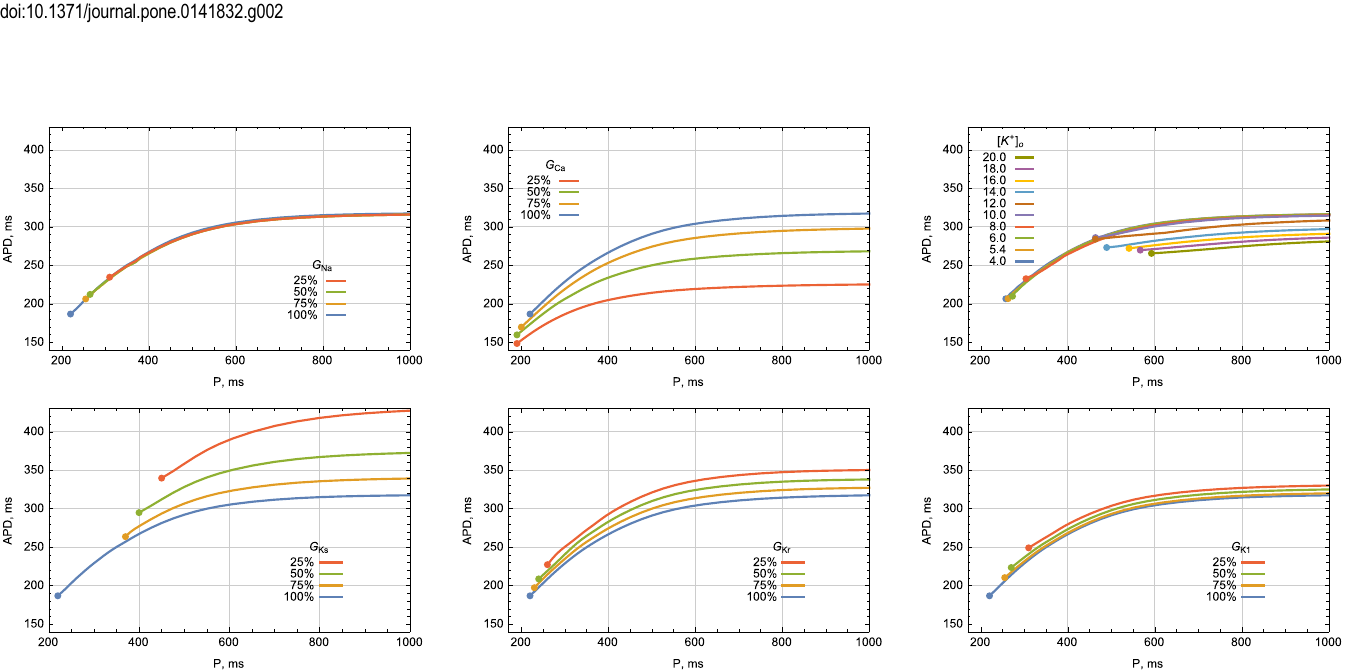
Fig 3. APD 90 restitution curves for various conductivities of ionic currents and external [ K + ] o concentration. (a) Inhibition of I Na ; (b) Inhibition of I Ca ; (c) Hyperkalemia. (d) Inhibition of I Ks ; (e) Inhibition of I Kr ; (f) Inhibition of I K 1 ; The graphs show the dependency of APD 90 on the period of stimulation. Data from S1 Table was used. The blue line on each graph corresponds to the normal parameter values. Different colors show the curves for decreased values of the various ionic conductivities or external [ K + ] o concentration, marked in the frame of each sub-figure. Frequencies higher than 2.7 Hz were obtained by gradually decreasing the period by 5 ms per cycle.